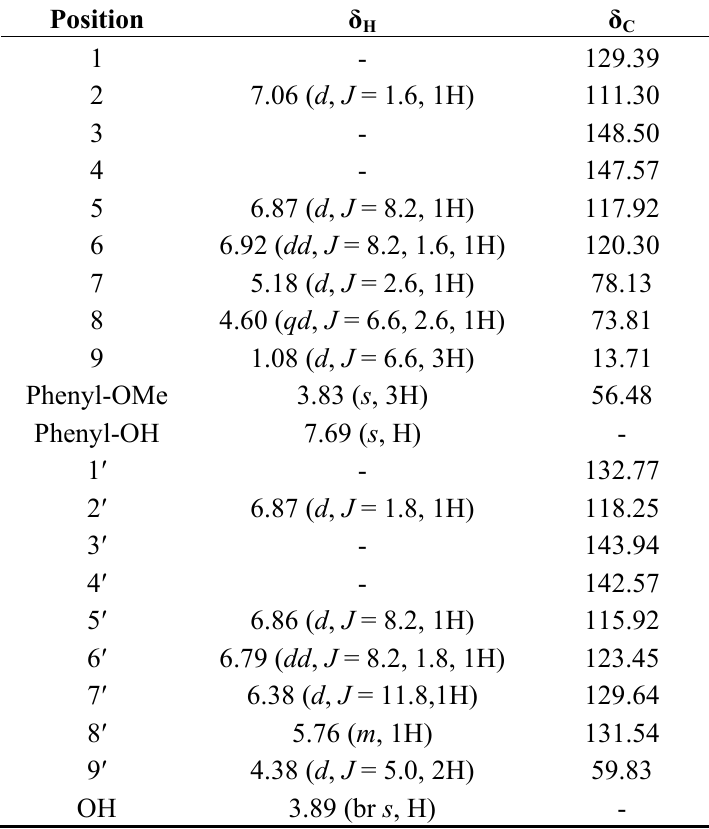
COCD ) of 1 . δ in ppm, J in 3 3